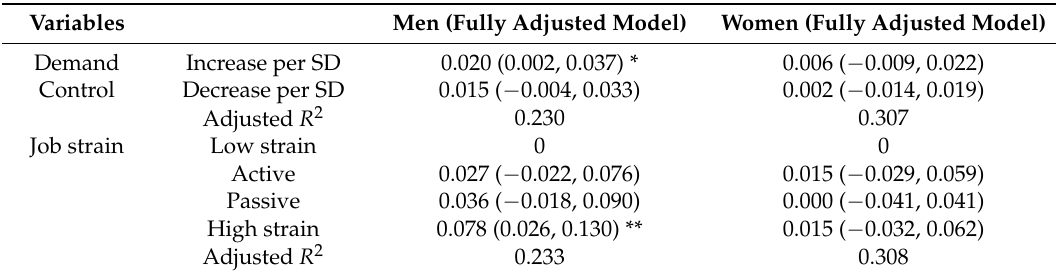
Table 5. Associations of job strain with arterial stiffness in men ( n = 858) and women ( n = 1283) ( β coefficients with 95% confidence intervals